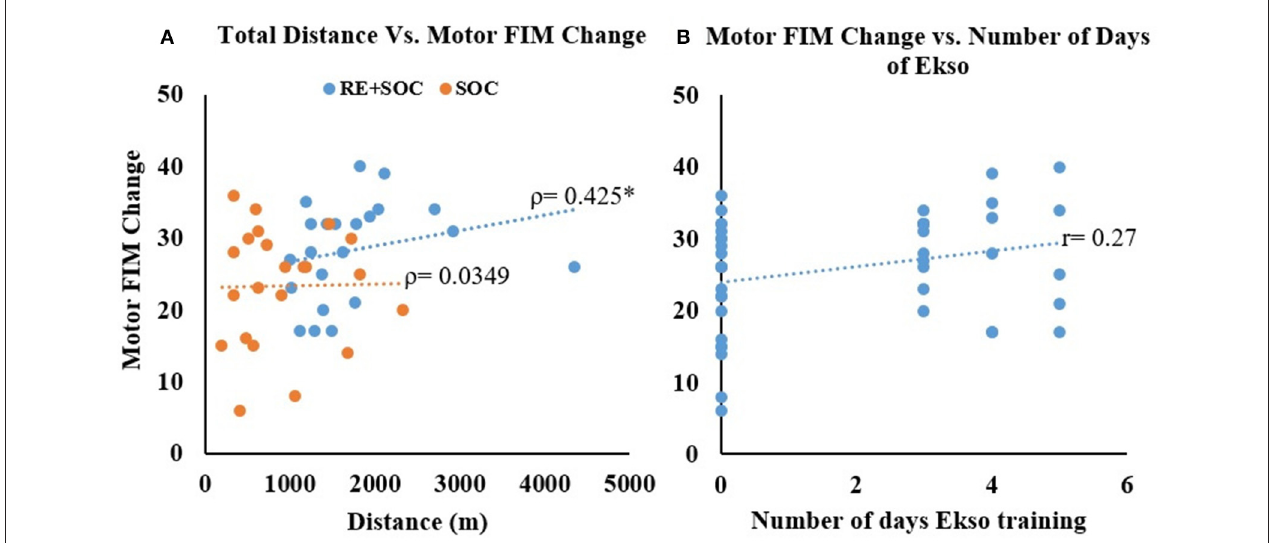
FIGURE 4 | (A) The relationship between total distance walked and change in motor FIM from admission to discharge. (B) The relationship between number of days of RE training and change in motor FIM from admission to discharge for all participants. *Significance of p <